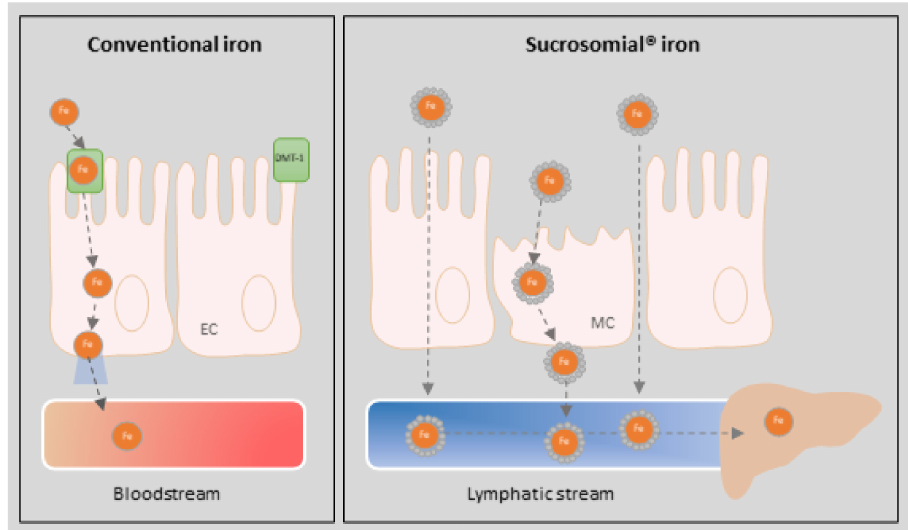
Figure 1. Schematic representation of absorption mechanisms of conventional iron and Sucrosomial ® iron (Pharmanutra Spa, Scientific Department, Pisa, Italy). EC, endothelial cells; MC, M